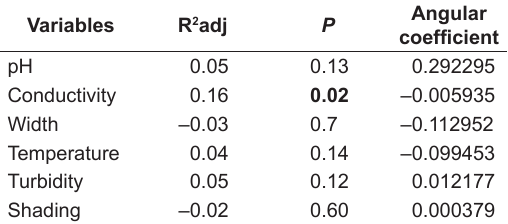
Figure 4. Path diagram, showing the direct and indirect effects of local and landscape variables on chlorophyll- a concentration. Values in bold indicate Table 4. Isolated importance of the local environmental components (R 2 adj) and slope of the relationship of the local environmental variable with chlorophyll- a concentration.